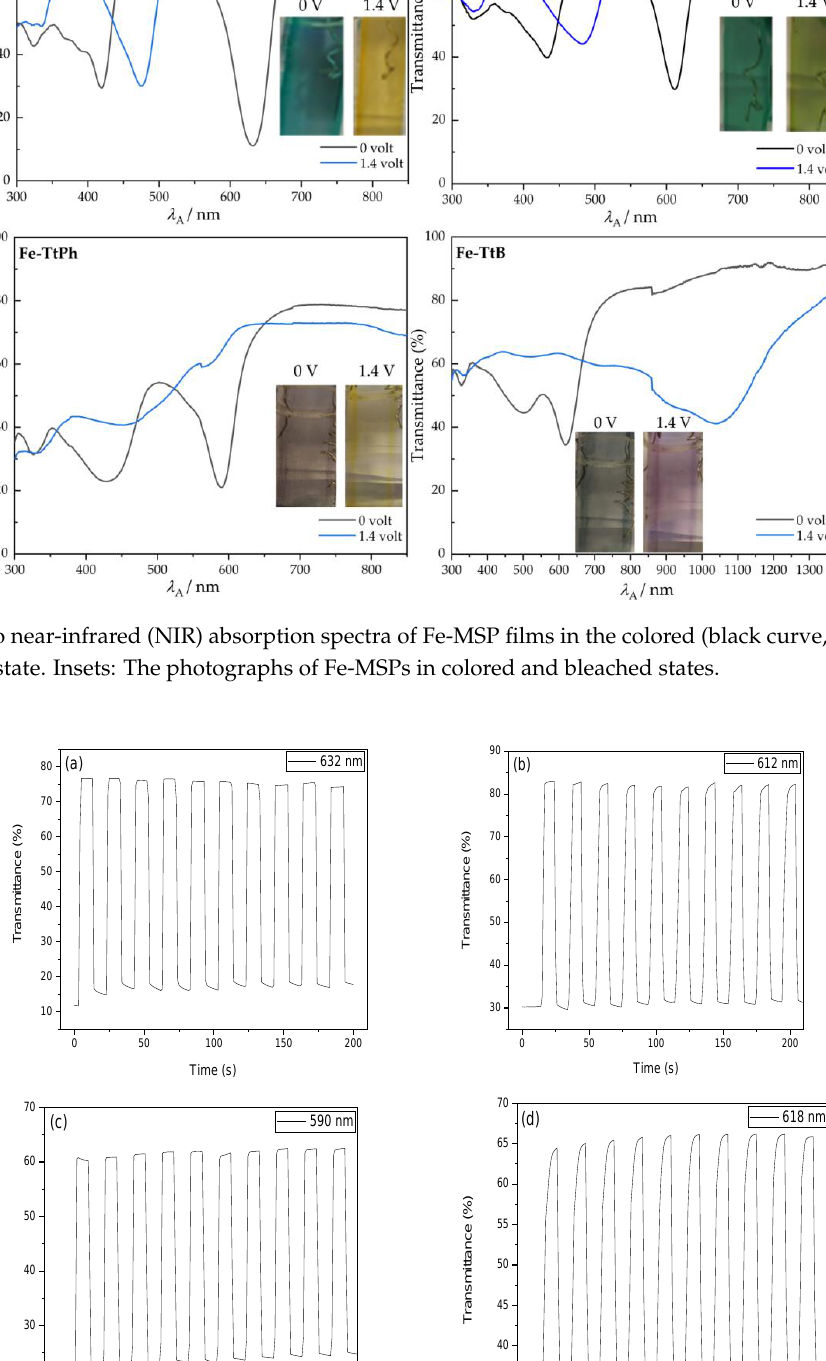
(d) Figure 6. Chronoamperometry of ( a ) Fe-Tt ( b ) Fe-TtE ( c ) Fe-TtPh and ( d ) Fe-TtB films with a 10 s delay between 0 V and 1.4 V.